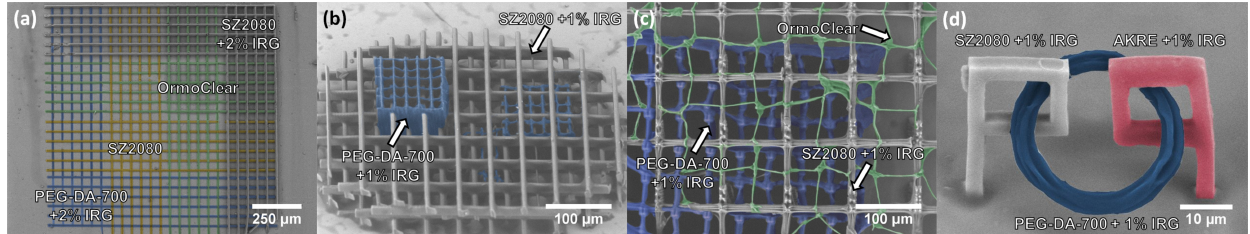
free-standing structures fabricated out of different materials connected with a freely moving ring fabricated out of the third